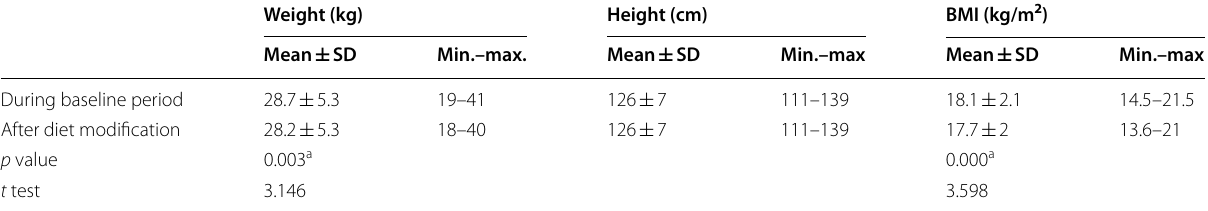
a Means highly significant, t test: paired t test